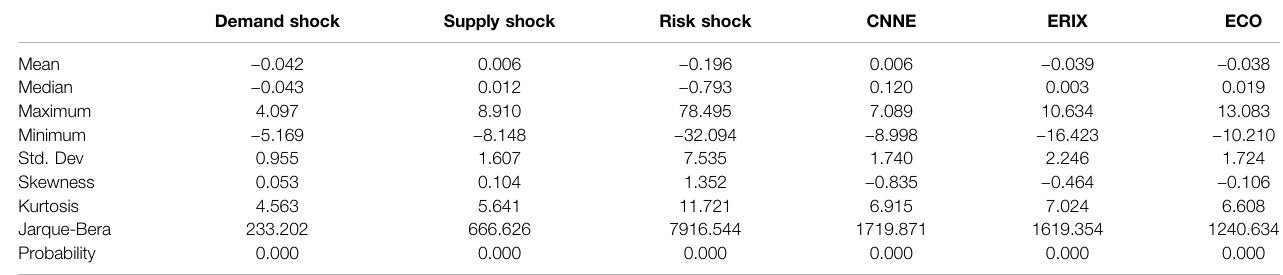
TABLE 1 | Descriptive analysis of oil shocks and new energy returns.